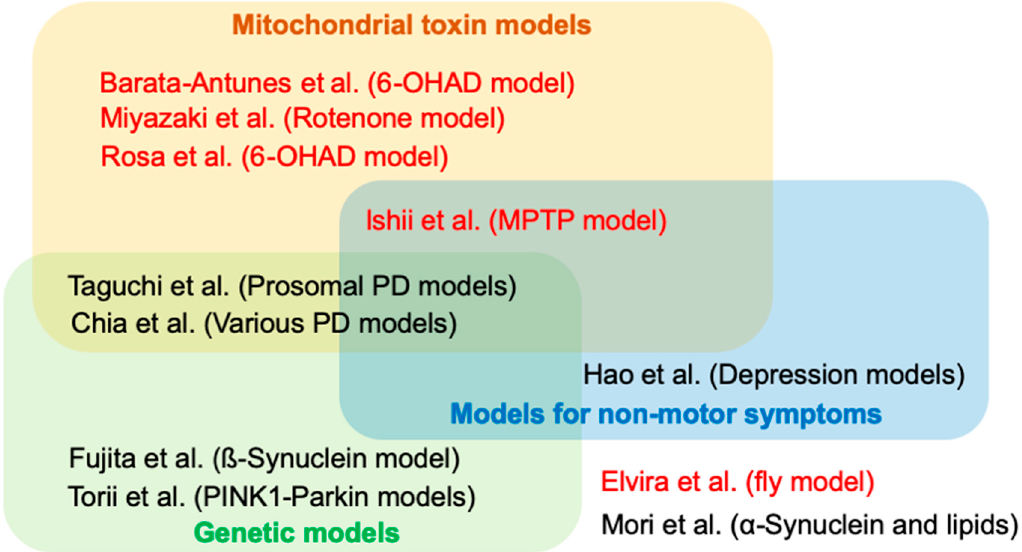
Figure 1. Summary of papers in this Special Issue. Articles in red and in black indicate original and review articles, respectively. 6-OHDA = 6-hydroxydopamine, MPTP = 1-methyl-4-phenyl-1,2,3,6-tetrahydropyridine, PD = Parkinson’s disease.